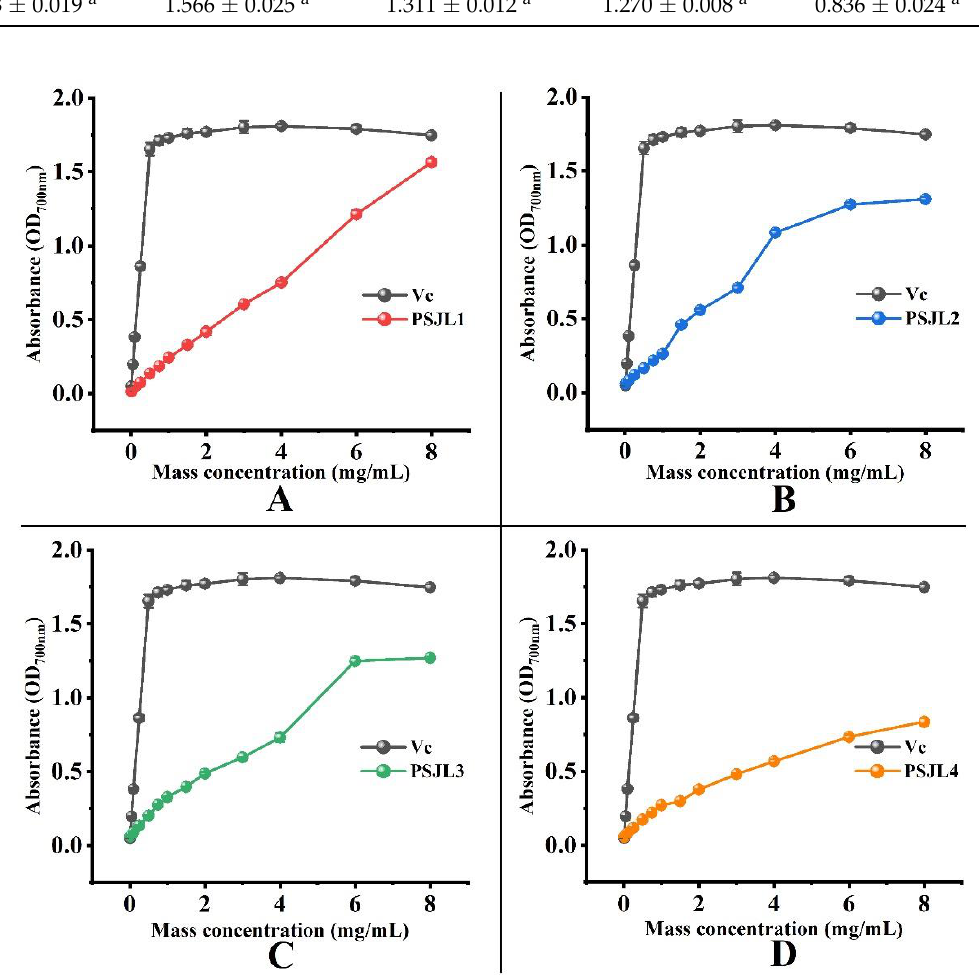
Figure 12. Comparison of FRAP by V C and PFSI. (( A – D ) represent samples of PFSI-1, PFSI-2, PFSI-3 and PFSI-4, respectively).